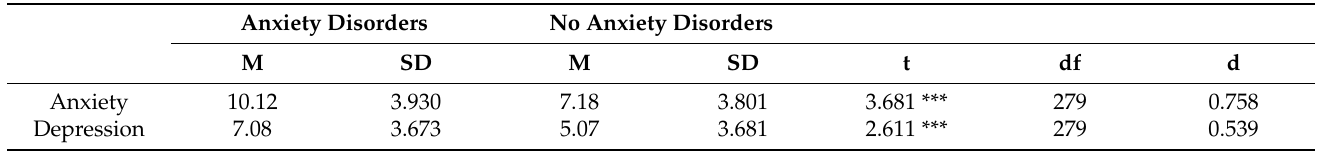
Table 6. Comparison of HADS scores for participants with and without anxiety disorders. Anxiety